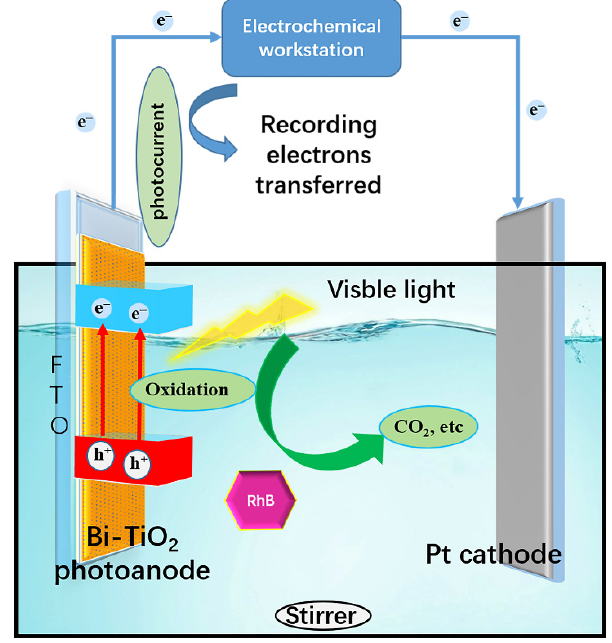
Figure 7. Structure of PFC connecting with the electrochemical workstation.